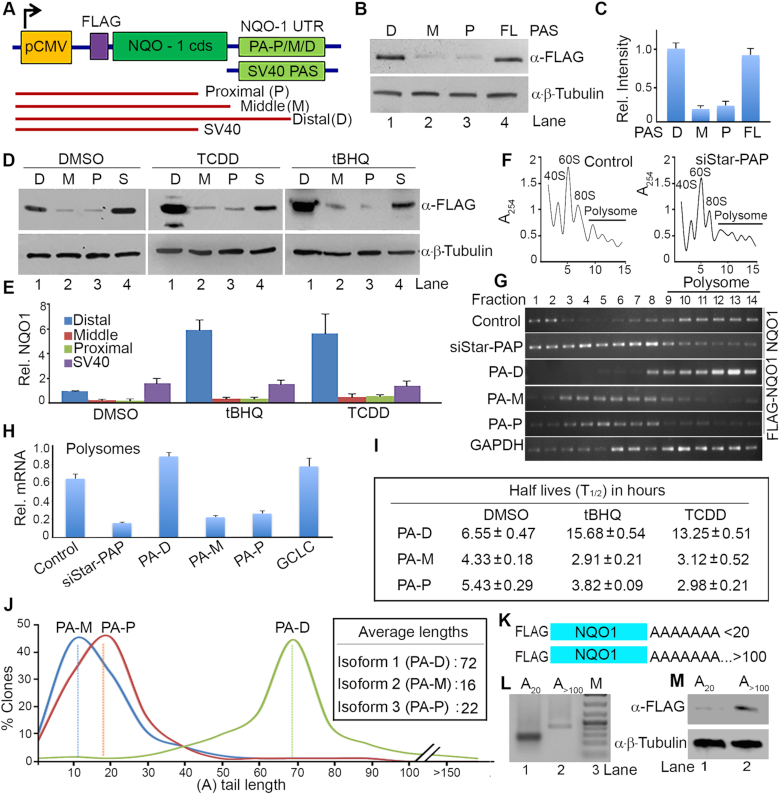

NQO1 APA generates mRNA isoforms with different translation efficiencies that is linked with differential PA-tail length addition. (A) Schematic of a reporter mini gene construct of FLAG-NQO1 expressed from the CMV promoter and driven by each NQO1 PA-site (P-proximal, M-middle, and D-distal) or control SV40 3′-UTR. Sequences of respective 3′-UTRs are shown in Supplementary Figure S1. Red lines represent FLAG-NQO1 mRNA isoforms generated from the proximal, middle, or distal PA-site specific reporter constructs. (B, C) Western blot analysis and quantification of FLAG-NQO1 from HEK 293 cells after transfection of the three FLAG-NQO1 mini-gene reporter constructs. Quantification of band intensity was performed by using Image J software and is shown in C. Intensities (in arbitrary units) for each band was normalized with β-tubulin and expressed as fold difference in relative intensity with respect to the control DMSO treated sample. Error bar represents SEM of n = 3 independent experiments. (D, E) Western blot analysis and quantification of FLAG NQO1 after transfection of different FLAG-NQO1 reporter mini-gene constructs driven by the three PA-sites (distal-D, middle-M, proximal-P) in the presence and absence of tBHQ (100 μM for 4 h) or TCDD (100 nM for 24 h) treatment as indicated. Quantification of the blot is shown in E. Intensities (in arbitrary units) for each band was normalized with β-tubulin and expressed as fold-difference in relative intensity with respect to the distal-site DMSO treated sample. Error bar represents SEM of n = 3 independent experiments. (F) Representative polysome profile of HEK 293 cells in the presence and absence of Star-PAP knockdown after fractionation with 10–50% sucrose density gradient of 15 fractions. Ribosomal RNA content measured at 254 nm was plotted against fraction numbers. The top of the gradient is on the left, peaks representing monosomal fractions, and polysomal fractions are indicated. (G) RNA isolated from each fraction from the density gradient was analyzed for polysomal association of FLAG-NQO1 (transfected reporter NQO1), endogenous NQO1, and GAPDH mRNA (from control sample) by semi-quantitative RT-PCR. (H) qRT-PCR analysis endogenous NQO1 mRNA or FLAG-NQO1 mRNA in the combined polysomic fractions of the density gradient (9–14 fractions). NQO1 or control GCLC mRNA levels normalized to GAPDH are expressed relative (percent) of total mRNA. Error bar represents SEM of n = 3 independent experiments (P-values: 0.003, 0.01, 0.008, 0.03, 0.02, and 0.006 for control, siStar-PAP, PA-D, PA-M, PA-P, and GCLC respectively). (I) Half-life (T\documentclass[12pt]{minimal}
\usepackage{amsmath}
\usepackage{wasysym}
\usepackage{amsfonts}
\usepackage{amssymb}
\usepackage{amsbsy}
\usepackage{upgreek}
\usepackage{mathrsfs}
\setlength{\oddsidemargin}{-69pt}
\begin{document}
}{}$\frac{1}{2}$\end{document}) measurement of each NQO1 isoform encoded by proximal (P), middle (M) or distal (D) PA-sites after transcription inhibition with actinomycin D under conditions as indicated. T\documentclass[12pt]{minimal}
\usepackage{amsmath}
\usepackage{wasysym}
\usepackage{amsfonts}
\usepackage{amssymb}
\usepackage{amsbsy}
\usepackage{upgreek}
\usepackage{mathrsfs}
\setlength{\oddsidemargin}{-69pt}
\begin{document}
}{}$\frac{1}{2}$\end{document} is expressed in hours. Data are mean ± SEM of n = 3 independent experiments. (J) PA-tail length distribution of NQO1 mRNA isoforms encoded by distal, middle or proximal PA-sites (sequenced from >200 clone each), and average PA-tail length is indicated in the inset. (K) Schematics of the RNA template for in vitro translation generated from distal PA-site with short A (A16) and long A (>A100, after polyadenylation of the A16NQO1 template). (L) Agarose gel analysis of both short and long A NQO1 RNA templates as in K. (M) In vitro translation using HeLa cytoplasmic lysates with in vitro transcribed NQO1 RNA template generated from the distal PA-site with short A (A16) and long A (>A100, after polyadenylation of the A16NQO1 template).